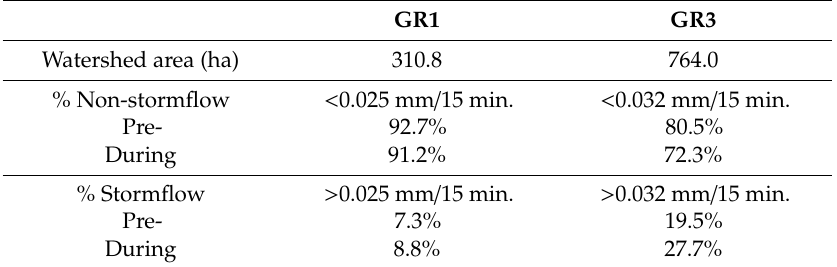
Table 1. Stormflow versus non-stormflow proportions for streamflow at GR1 and